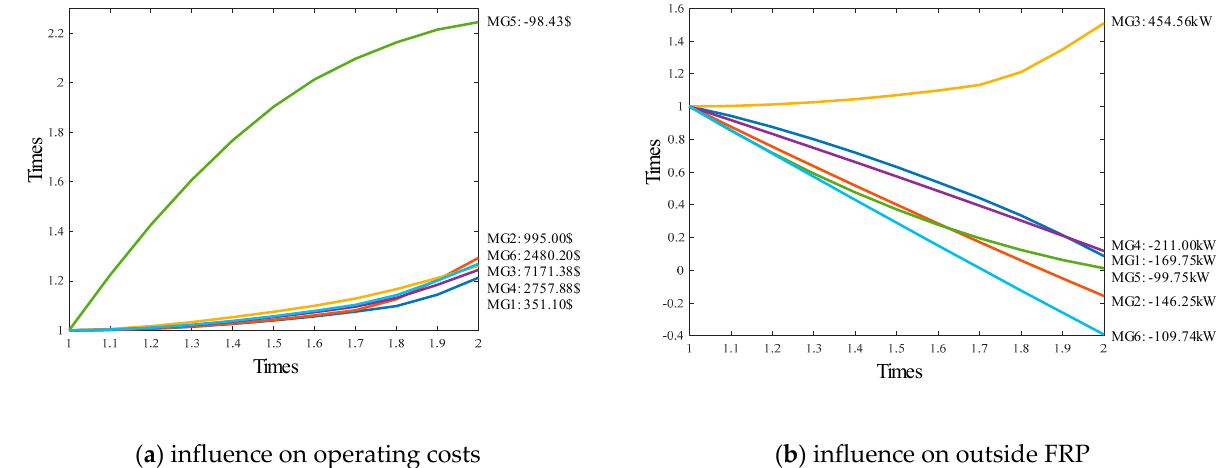
Figure 8. The influence of electricity price on dispatching results of MGs. The P ADN,F and network losses of ADN1 and ADN2 in different iterations are pre- sented in Figure 9. Eleven and thirteen iterations are performed on ADN1 and ADN2, respectively. The prices for an FRP in ADN2 reach the upper limitations. P ADN,F of ADN1 are lower than 0 under the initial prices for an FRP and eventually, converge to values above 0 with the growth of prices. The P ADN,F of ADN2 are still below 0 under the maximum price for an FRP; however, the increases in charges for an FRP reduce its uncertainties. As shown in Figure 10, owing to the rise of the weight coefficient, the convergence of the network losses is accelerated, and the minimum values are achieved after five to six iterations.